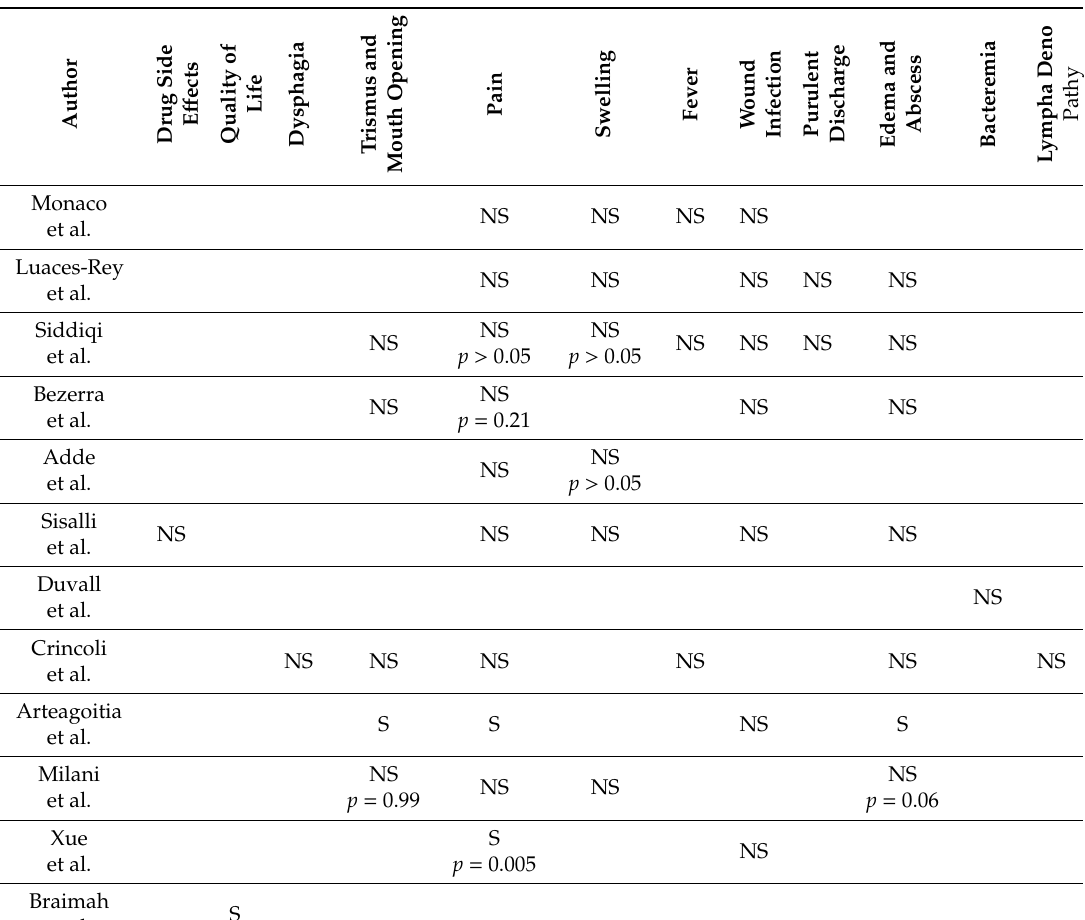
Table 3. Evidence from the